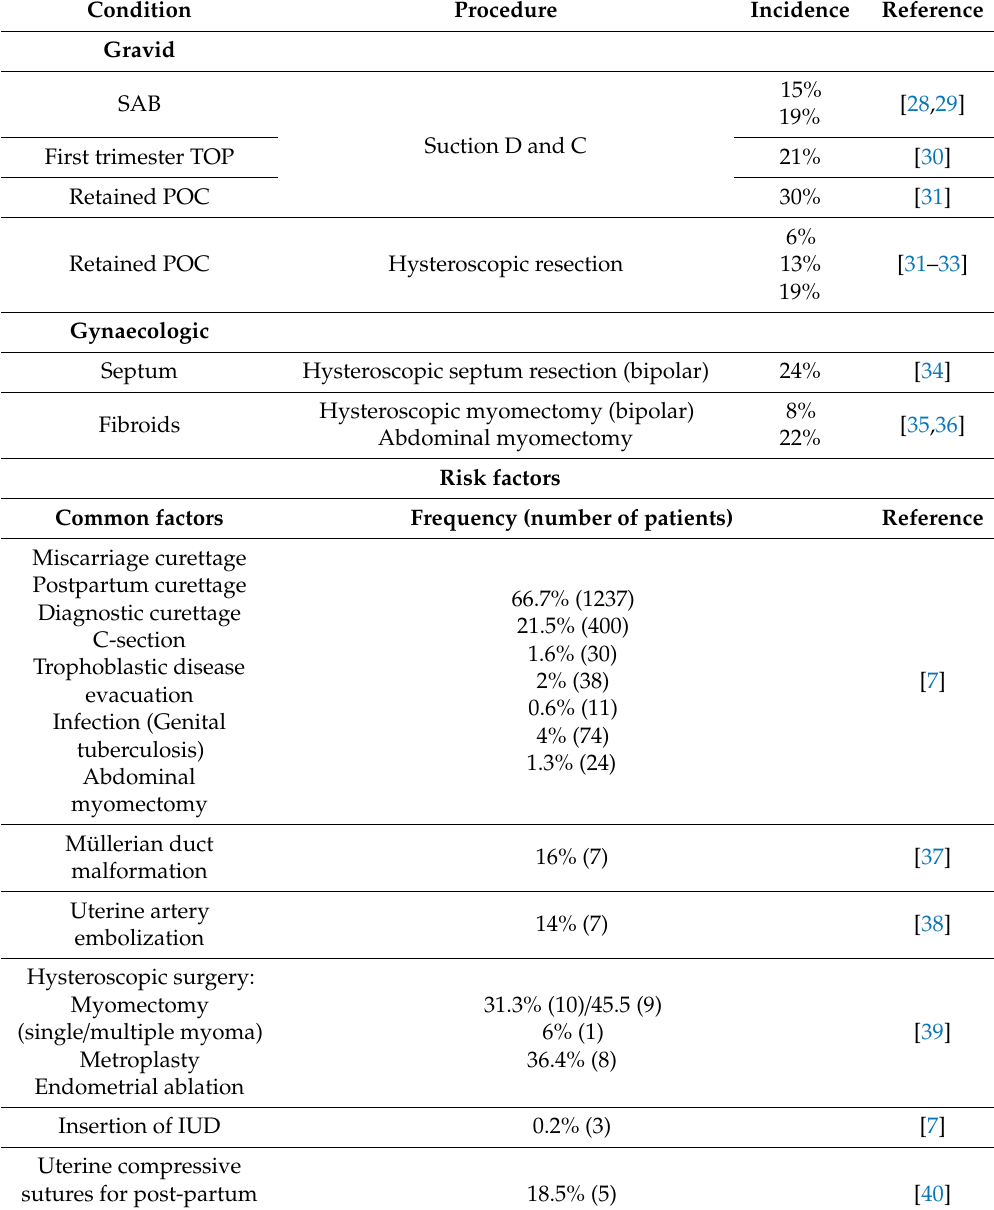
Table 2. Incidence-prevalence and risk factors associated with intrauterine adhesion (IUA)